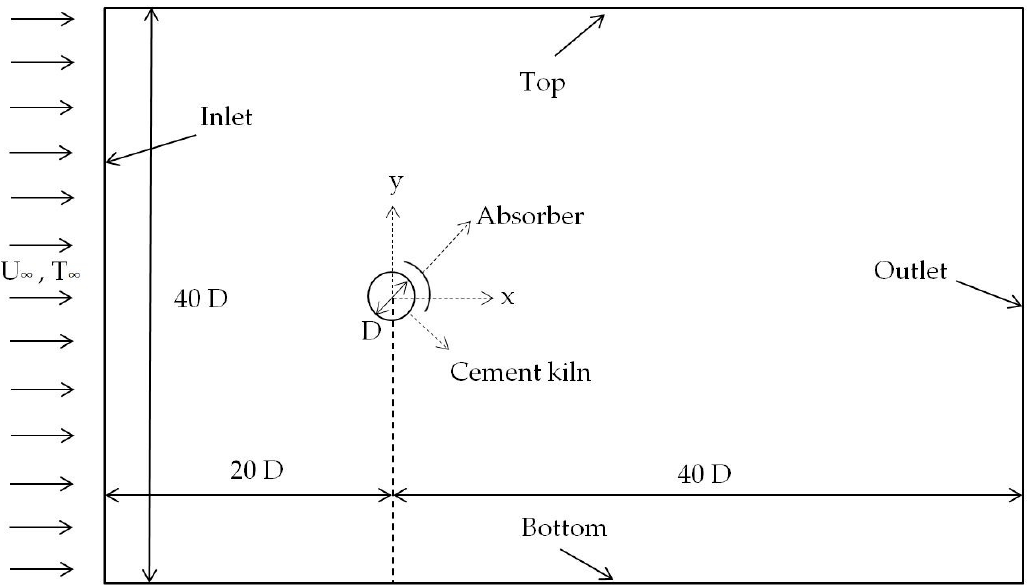
Figure 1. Schematic view of the two-dimensional (2D) computational domain ( U ∞ : free stream velocity, T ∞ : ambient temperature, D: kiln diameter, x, y: Cartesian coordinate system).